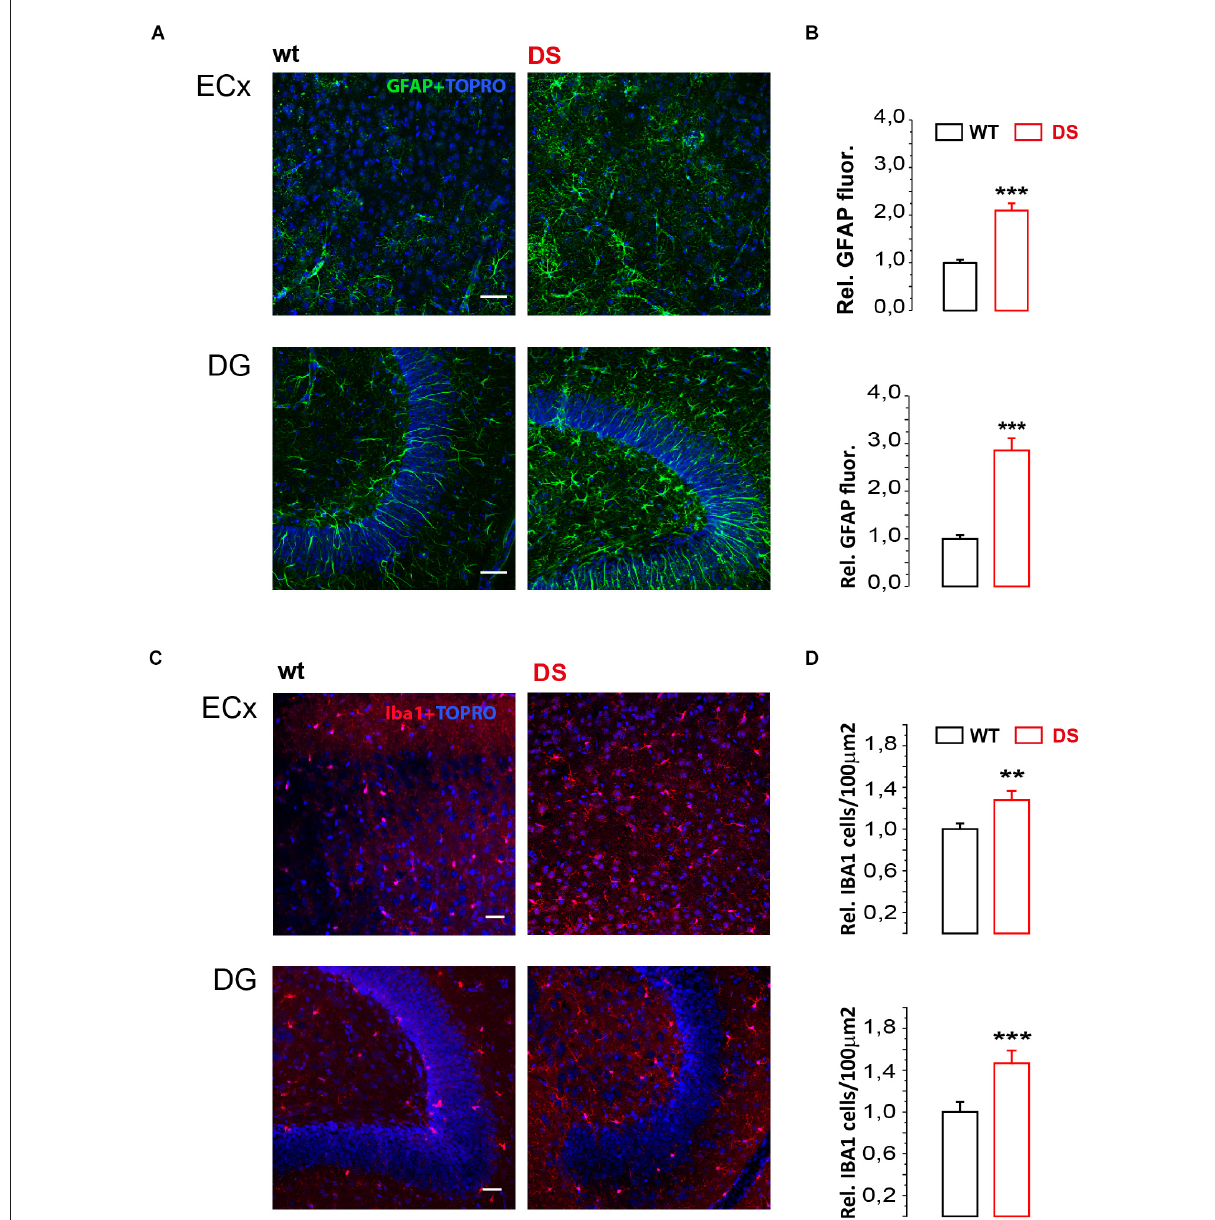
FIGURE3 Glial cell markers GFAP and Iba1 are increased in DS mice. (A,C) Confocal fluorescence images of GFAP and Iba1 immunofluorescence in ECx and DG from 19 to 21 days old DS mice (Na v 1.1 +/- ) and same age littermate wild type (wt) controls. (B) Histogram (mean ± SEM) summarizing the relative GFAP fluorescence in DS mice compared to wt mice from ECx ( n = 3 mice PN 19–21, 6 ECx, 18 fields for WT and DS mice p < 0.001, one sample t -test) and DG ( n = 3 mice PN 19–21, six DG, 18 fields for WT and DS mice p < 0.001, one sample t -test). (D) Histogram (mean ± SEM) summarizing number of Iba1 positive cells/ µ 2 in DS compared to WT mice from ECx ( n = 4 mice PN 19–21, eight Ecx, 24 fields for WT and DS mice p = 0.00817, two sample t -test) and DG ( n = 4 mice PN 19–21, eight DG, 24 fields for WT and DS mice p = 0.0038237, two sample t -test). ∗∗ p ≤ 0.01, ∗∗∗ p ≤